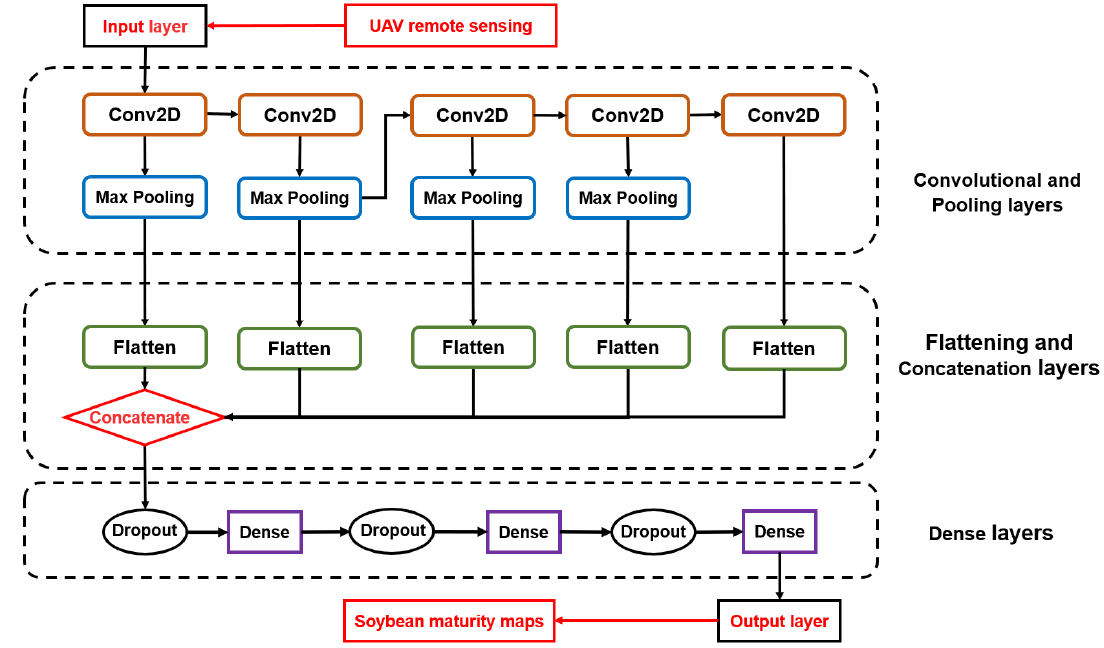
Figure 3. Architecture of